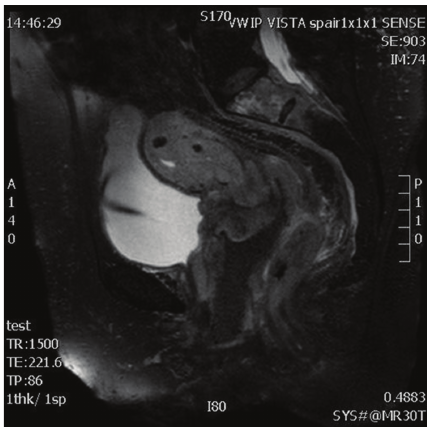
Figure 1: 3D VISTA T2-weighted sagittal MRI images of the pelvis. Images show a locally invasive tumor, with heterogeneous rather high intensity signal, most likely originating from the cervix with transmural invasion of the uterus. Invasion into the anterior part of the vagina, bladder, lumbosacral plexus, sacrum, and mesorectum. (The vagina, low/dark signal, was filled with a mixture of barium and gel at the start of the MRI examination for accurate evaluation of vaginal wall.)